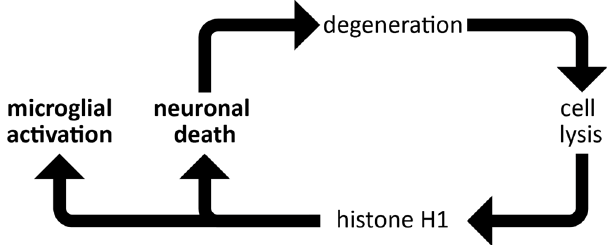
Figure 11. Histone H1 drives neuroinflammation through a positive feedback loop. Histone H1 released from dying neurons causes cell death of neighbouring neurons and simultaneously promotes pro-inflammatory responses in microglia and astrocytes, which may then exacerbate